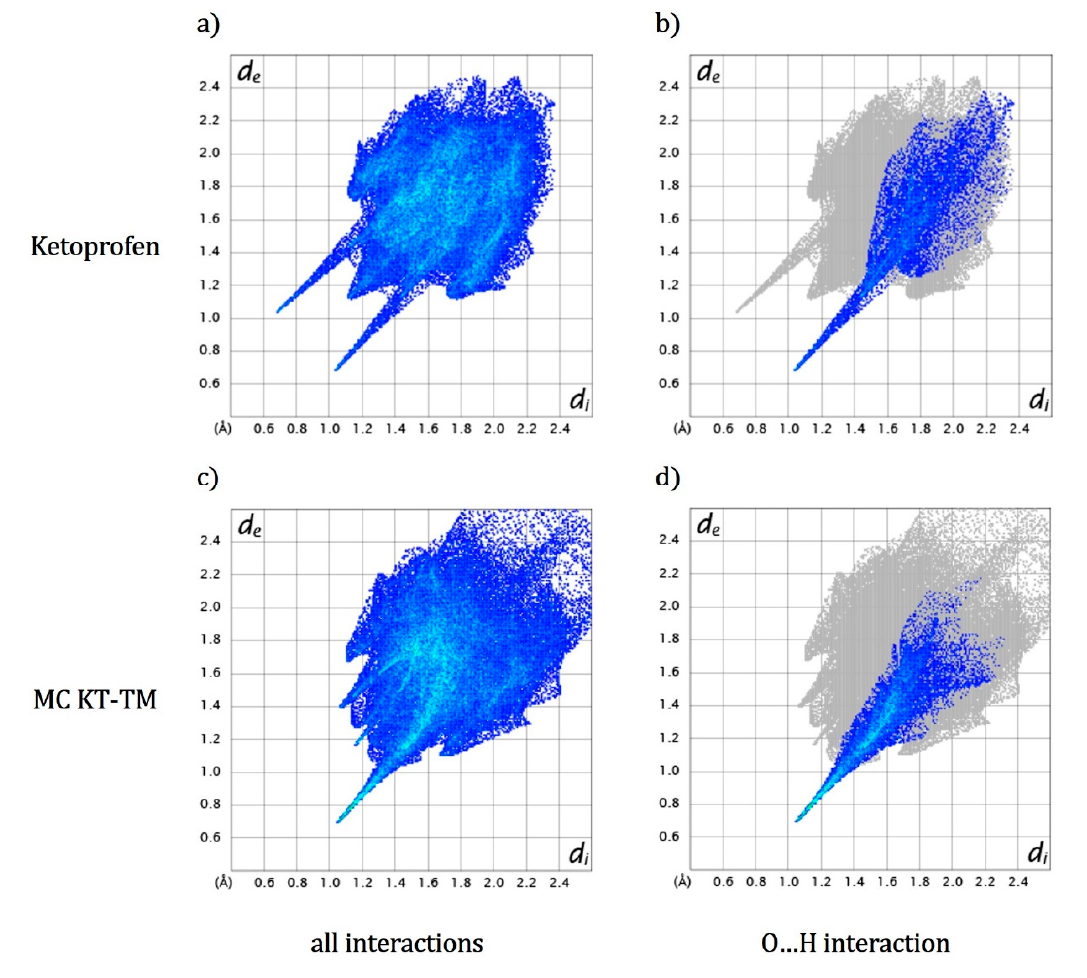
Figure 11. Two-dimensional fingerprint plots of ( a ) intact ketoprofen/all interactions, ( b ) intact ketoprofen/O-H interaction, ( c ) multicomponent crystal of ketoprofen and tromethamine/all interac- tions, and ( d ) multicomponent crystal/O-H interaction.